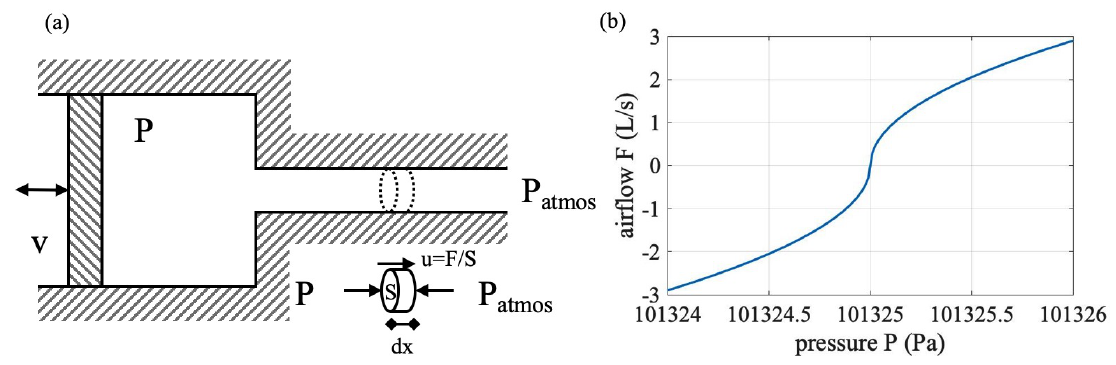
Figure 8. ( a ) An ideal model for The airflow (F)-pressure (P) relationship inside a chamber. ( b ) The theoretical relationship between F and